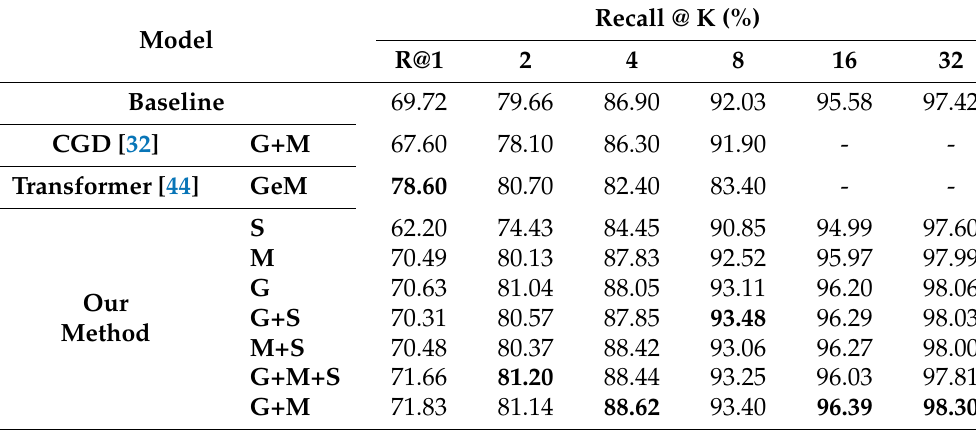
Table 5. Full results with the best hyperparameters regarding the combination of global descriptors. The bold values are the best performances in each recall @